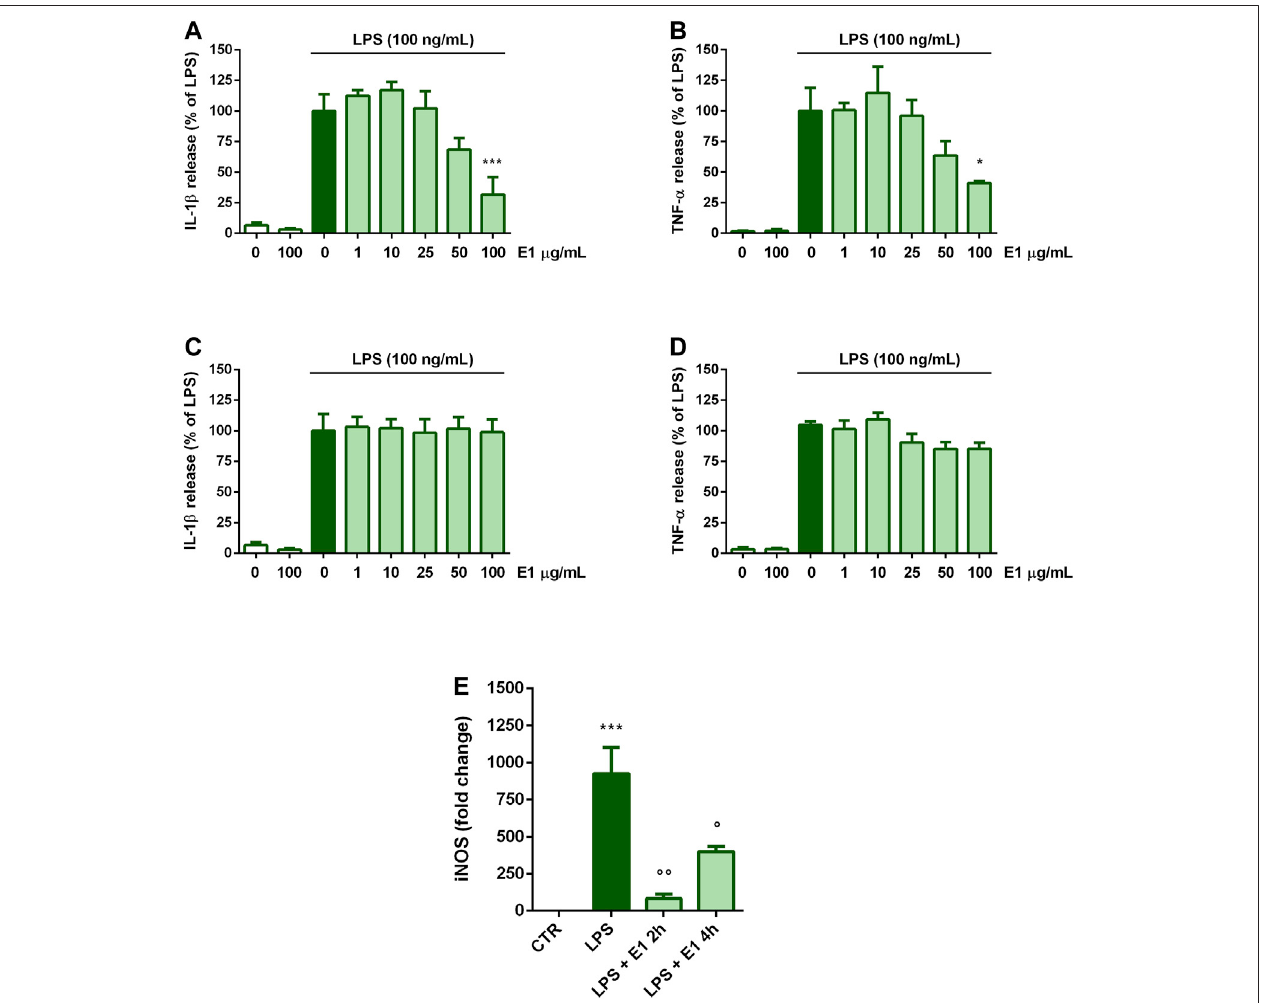
FIGURE 4 | Effect of post-treatment with Spirulina extract on cytokine release and iNOS gene expression in LPS-stimulated cortical microglia. Microglia were cultured for 24 h in 10% serum-containing medium, which was replaced with serum-free medium before stimulation with 100 ng/ml LPS. (A,B) Two, or (C,D) 4 h later cells were treated with E1 (1 – 100 μ g/ml). Supernatants were collected and analyzed for IL-1 β and TNF- α release. Results are expressed as percentage of cytokine release relative to LPS-stimulated microglia (dark green bars). Data are means ± SEM of three independent experiments. * p < 0.05, ** p < 0.01, and *** p < 0.001 versus LPS stimulation (E) One or 4 h after LPS stimulation cells were treated with 100 μ g/ml E1 and iNOS mRNA levels were quanti fi ed by real-time PCR. Data are presented as means ± SEM ( n (cid:1) 3 in triplicate). *** p < 0.001 compared to control cells; °° p < 0.05 and ° p < 0.01 versus LPS stimulation. One-way ANOVA followed by Sidak ’ s multiple comparison test.